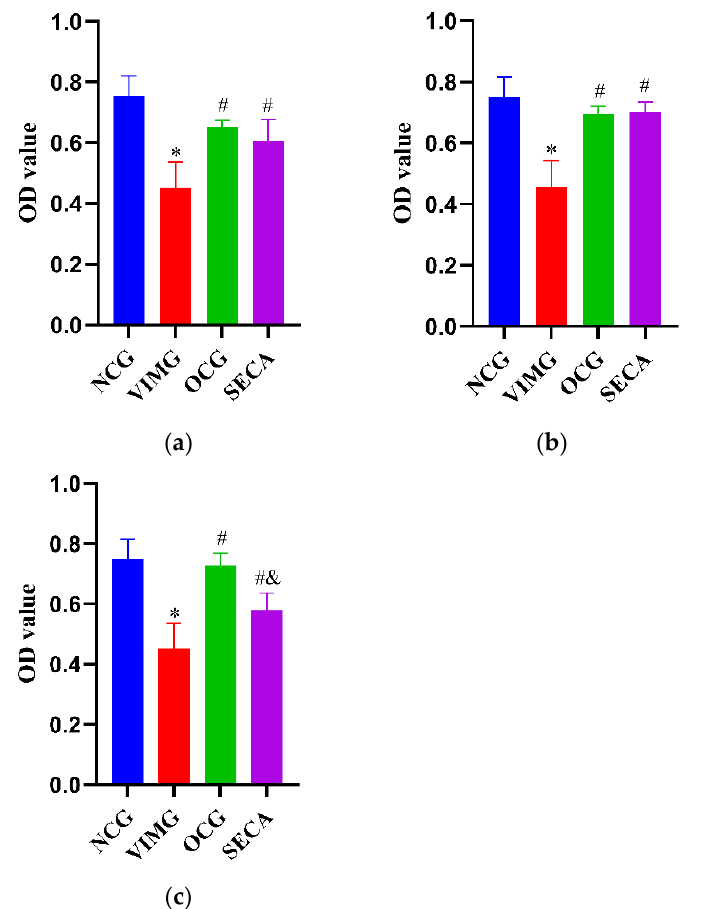
Figure 3. Effect of SECA on H1N1 via premixed administration ( a ), prophylactic administration ( b ), and therapeutic administration ( c ). Comparison with the negative control group (NCG), * p < 0.05. Comparison with the virus-infection model group (VIMG), # p < 0.05. Comparison with the